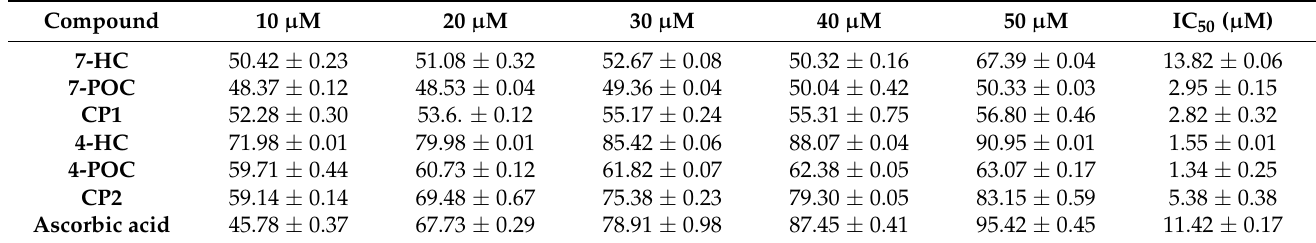
Table 1. Antioxidant capacity (%) of the synthesized compounds (DPPH method). a. Compound